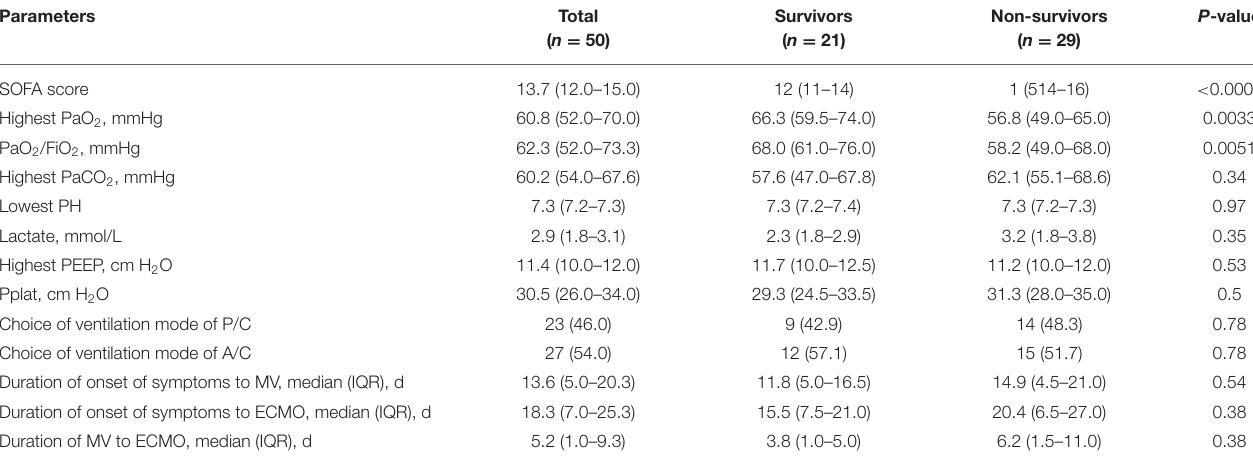
TABLE 2 | Lung function and treatment before the commencement of extracorporeal membrane oxygenation.